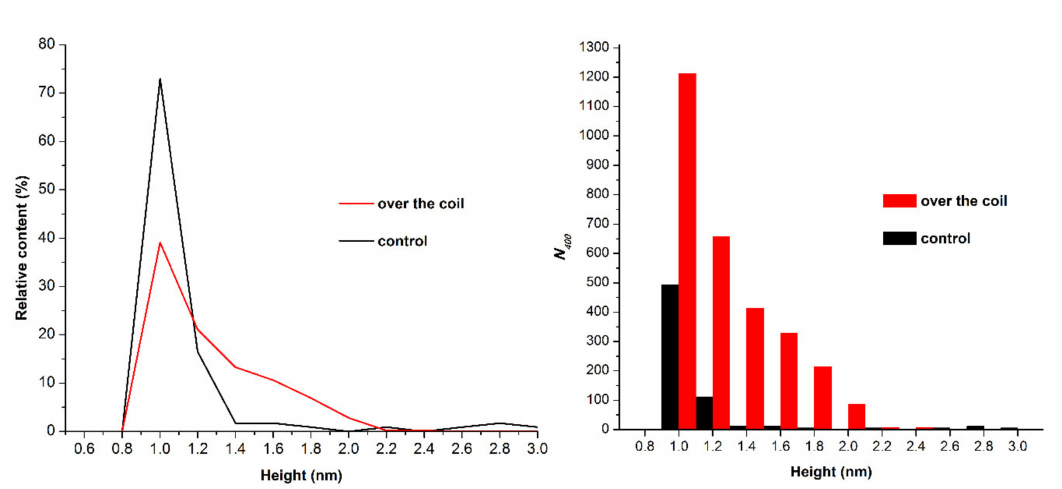
Figure 3. Results of the processing of data obtained upon the AFM analysis of HRP solutions: typical plots of the distribution of the imaged objects with height ρ ( h ) (left) and the number of visualized particles normalized per 400 µ m 2 area (right). The measuring cell (containing HRP solution) was placed either far away at a 10 m distance from the polymeric pipe coil (control experiment, black line and bars), or within the experimental setup over the coil (red line and